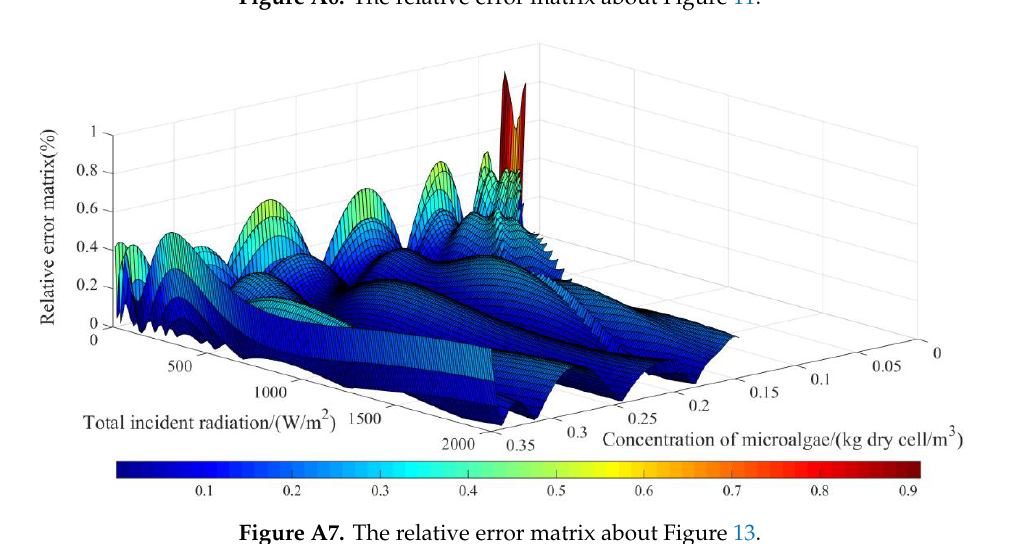
Figure A7. The relative error matrix about Figure 13.